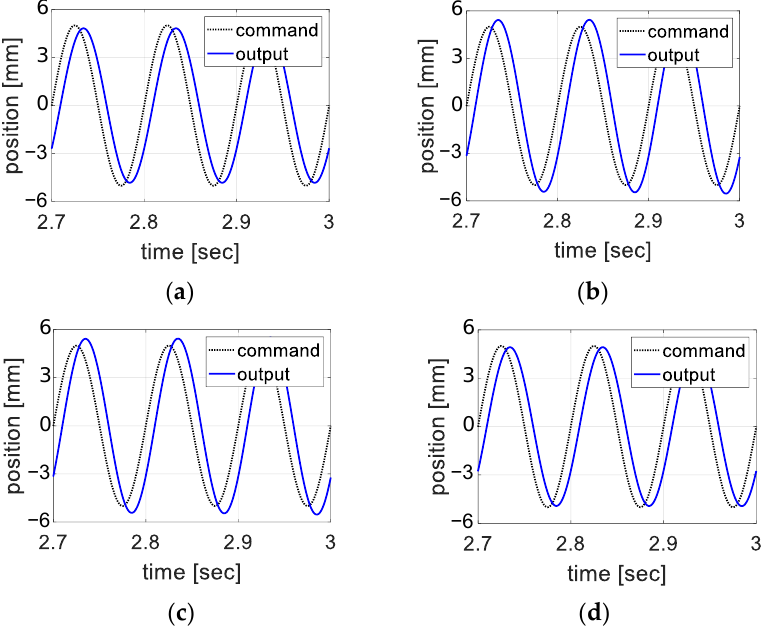
Figure 15. Commands and outputs: ( a ) Normal, ( b ) the zero output mode, ( c ) the fixed output mode, ( d ) the scaled-down mode.